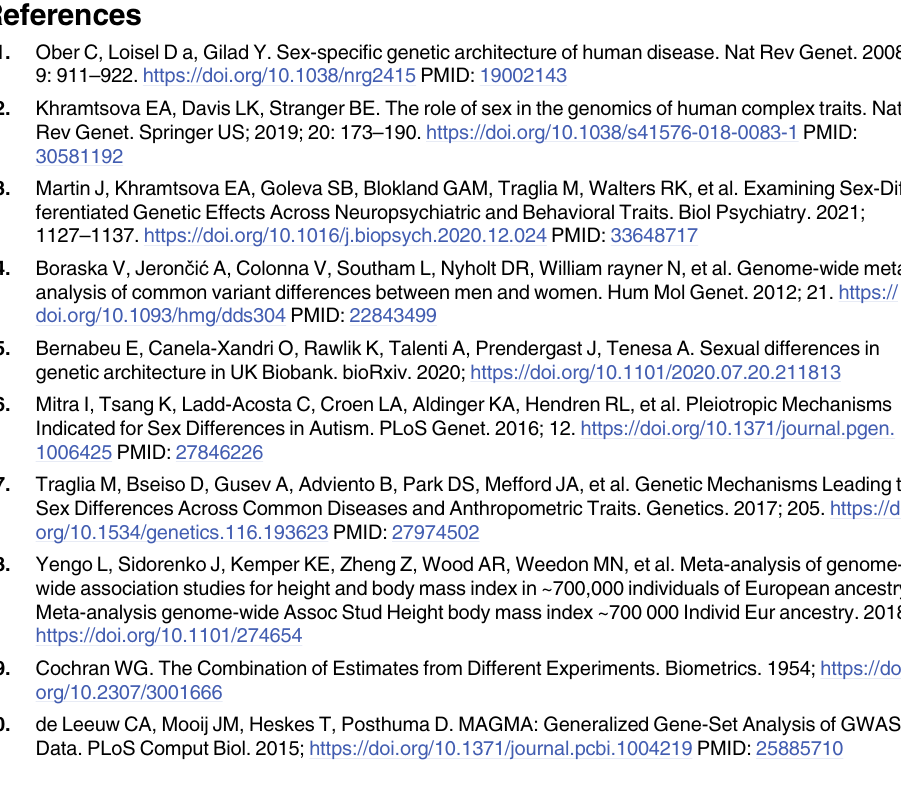
S8 Table. Enrichment of biometric trait sex-heterogeneous SNPs in summary statistics for N = 16 diseases and N = 17 human